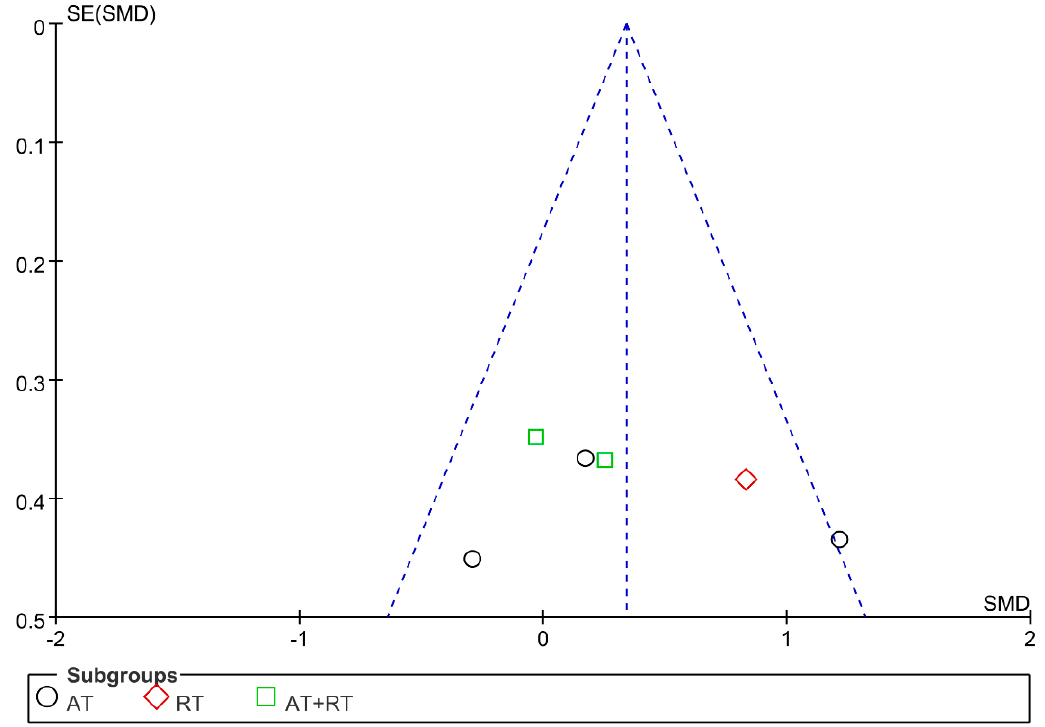
Figure 7. Publication bias of the influence of different exercise modalities on the level of TNF- α in adolescents with obesity.